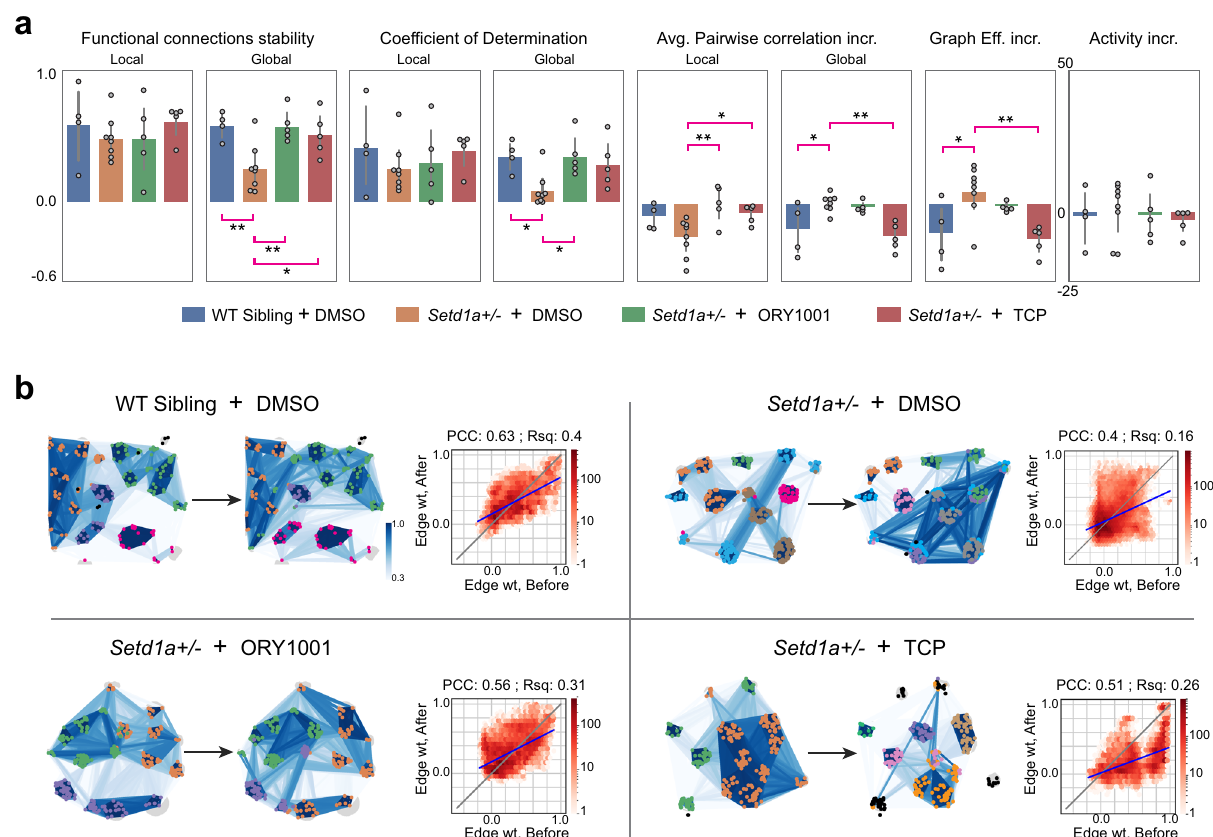
Fig. 7 Partial rescue of Setd1a + / − MoNNet network pathophysiology by pharmacological inhibition of LSD1 demethylase activity. a Barplots comparing various quantitative measures of network function of WT sibling MoNNets (blue) and Setd1a + / − MoNNets treated with DMSO(orange), ORY- 1001(green) and TCP(red). All treatments were for two days. From left to right: local and global functional connections stability as measured by the correlation in edge weights of functional graph before and after the treatment; local and global coef fi cient of determination (r-square fi t edge weights before and after treatment) quantifying the predictability of the after-treatment state; average pairwise correlation increment as measured by increase in correlation of same pair before and after, averaged over an entire MoNNet; global graph ef fi ciency increment measures of functional graphs; activity rate per minute. Statistical signi fi cance were calculated by using one-way ANOVA and Dunnett multiple comparison test with WT sibling or Setd1a + / − group as controls (***padj < 0.001; **padj < 0.01; *padj < 0.05). Error bars represent 95% con fi dence interval and center are means. All samples are biological replicates. b , Representative examples of WT sibling MoNNets and Setd1a + / − MoNNets treated with DMSO, ORY-1001, and TCP. Nodes belonging to same modules are colored same. Co-classi fi cation matrix heatmap and clustering dendrograms are shown to visualize the hierarchical relationship in modules activity. The density scatter plot compares edge weight before and after treatment. PCC: Pearson ’ s correlation coef fi cient of the scatter plot; Rsq: r-square measure of fi tness of linear regression fi t with a straight line. Source data are provided as a Source Data fi